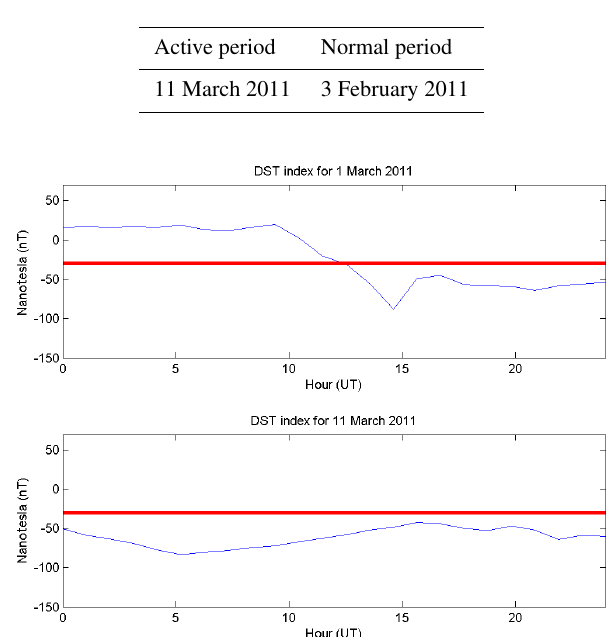
Figure 4. Comparison between geomagnetic storms on 1 March 2011 and 11 March